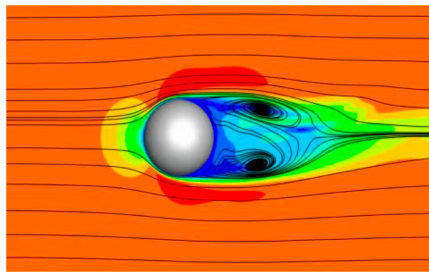
Figure 25. Streamlines and velocity contours for flow past a sphere at Re = 300. Table 5. The drag coefficient C D and the lift coefficient C L are listed at Re = 250 and averaged drag coefficient C D , averaged lift coefficient C L , and Strouhal numbers are listed at Re = 300.